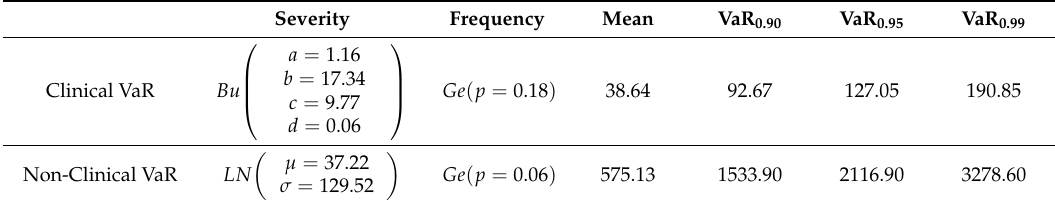
Table 7. Clinical-VaR and